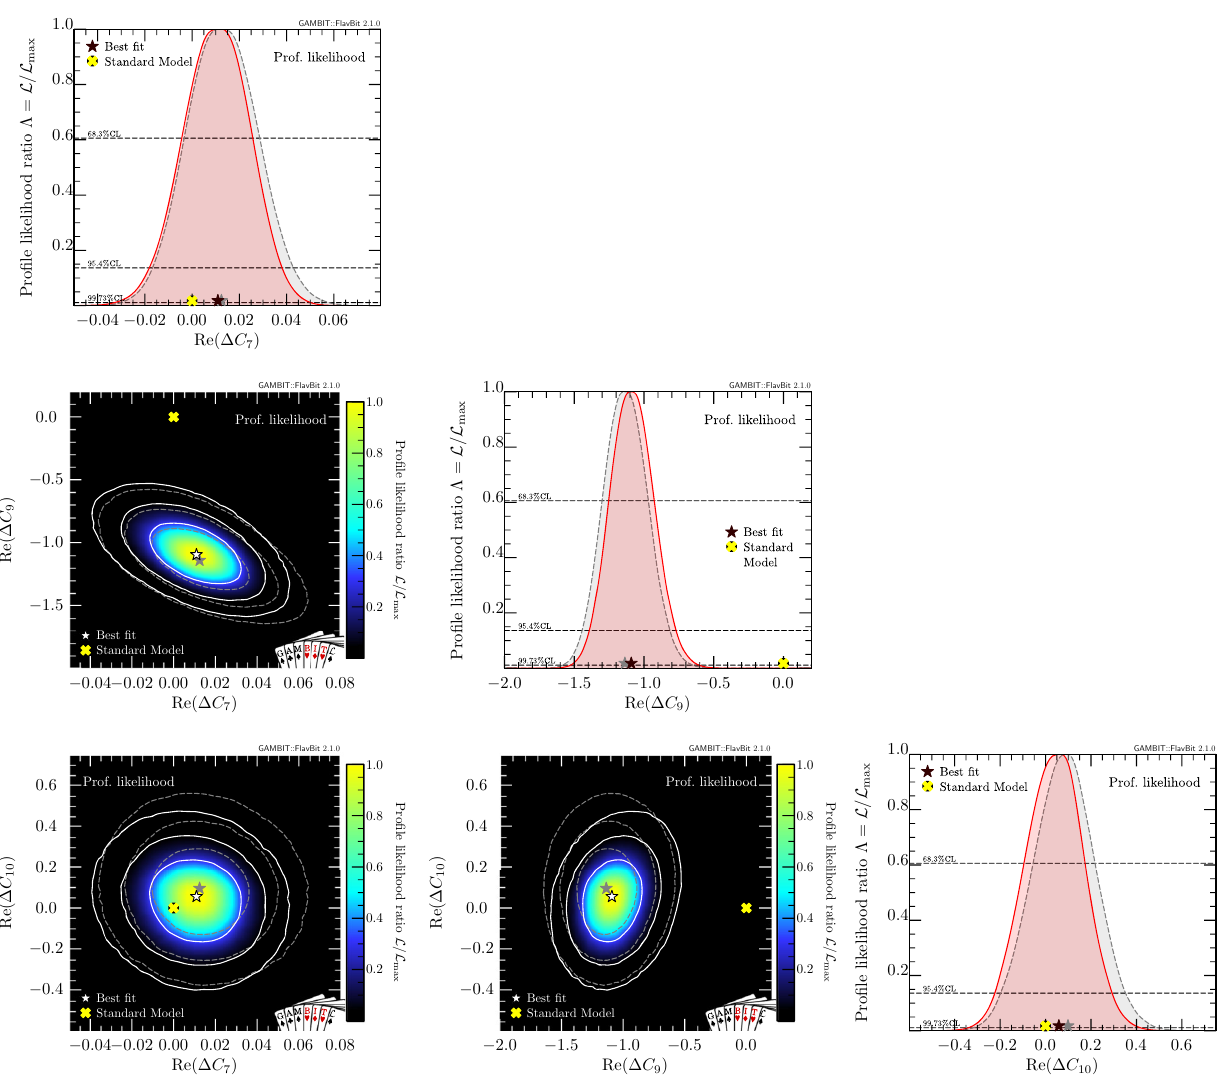
Fig. 1 Complete results of the combined fit to the Re ((cid:9) C 7 ) , Re ((cid:9) C 9 ) and Re ((cid:9) C 10 ) Wilson coefficients, showing one- and two- dimensional profile likelihoods of each parameter. Contour lines indi- cate 1, 2 and 3 σ confidence regions. White contours and coloured shading in two-dimensional planes, and red one-dimensional curves, show our main results, where we compute theory covariances self-